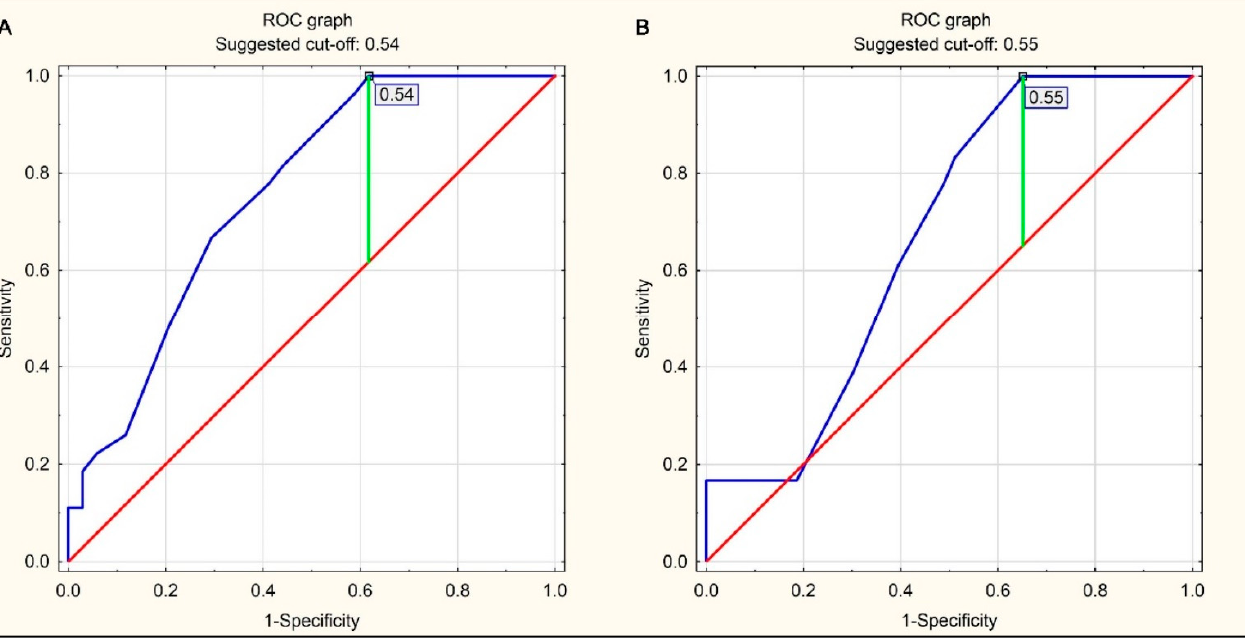
Figure 4. ROC curves for predicting right ventricular enlargement (RV/LV ratio ≥ 0.9 or RV/LV ratio ≥ 1.0 in pulmonary CTA) using the CTR value on the chest radiograph in the AP projection. ( A ) Right ventricular enlargement defined as RV/LV ≥ 0.9 in pulmonary CTA. ( B ) Right ventricular enlargement defined as RV/LV ≥ 1.0 in pulmonary CTA.